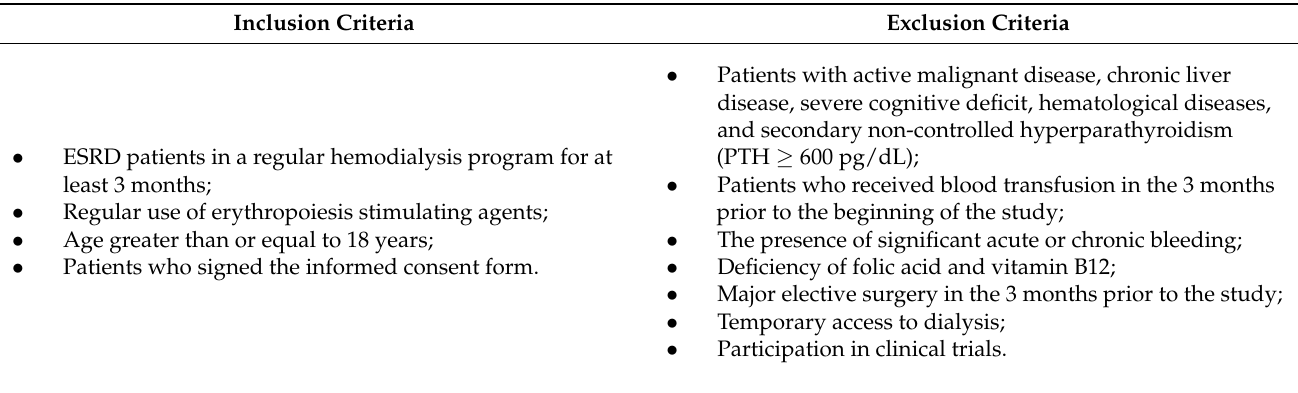
Table 1. Inclusion and exclusion